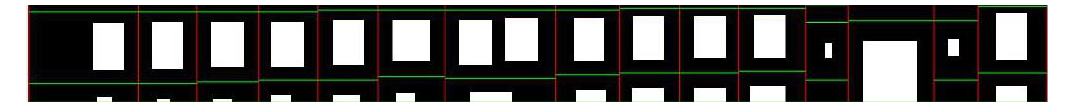
Figure 7. Partitioned façade without noise and extracted features